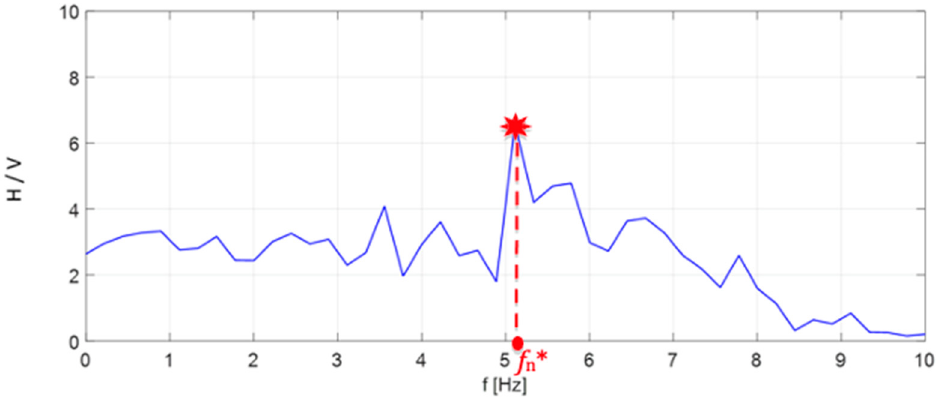
Figure 10. H / V vs. f curve obtained by the Fourier spectra shown in Figure 9 (23 May 2017): f n * is the natural frequency estimated by this curve.